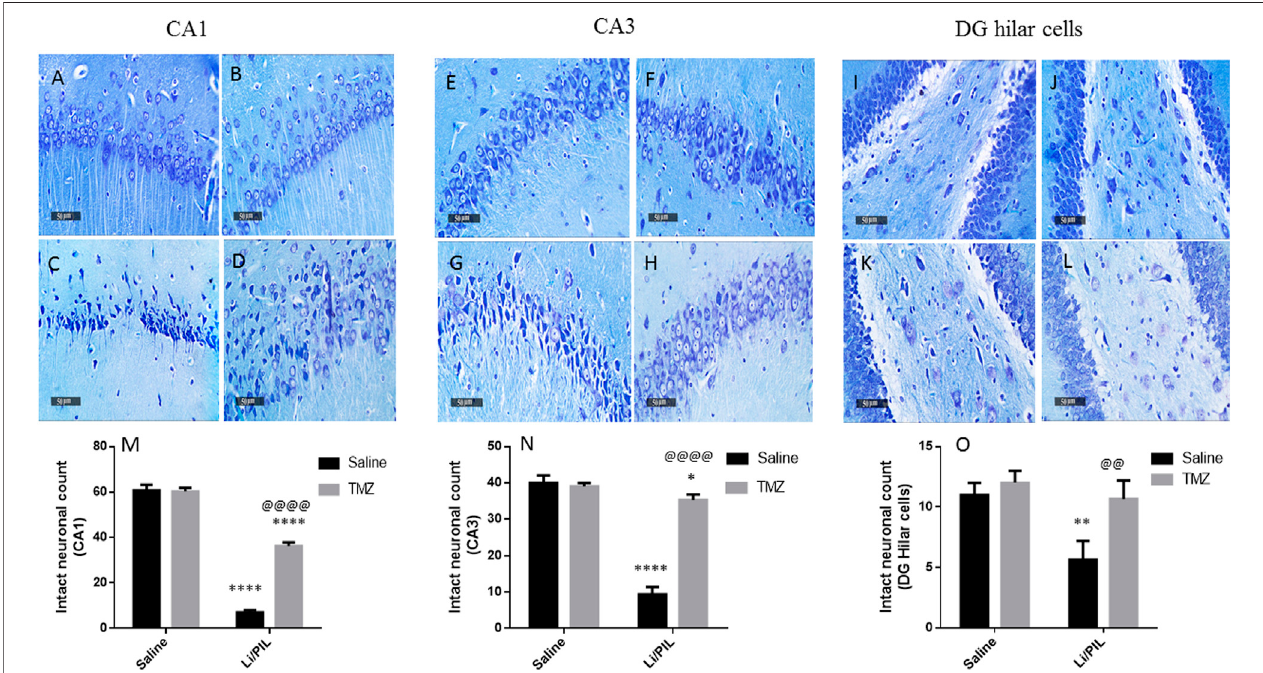
FIGURE 8 | Effect of TMZ on hippocampal neuronal loss of rats with Li/PIL-induced seizures. Photomicrographs demonstrating toluidine blue – stained hippocampaltissuesectionsofCA1andCA3subregionsandDChilarcellsinnormalcontrolrats (A,E,I) ,TMZcontrolrats (B,F,J) ,Li/PILcontrolrats (C,G,K) ,andTMZ+ Li/PILrats (D,H,L) .IntactneuronscountinCA1 (M) ,CA3 (N) ,andDGhilarcells (O) .Valuesareexpressed asmeanofthreeanimals ± SD.Two-wayANOVA followedby the Tukey – Kramer post-hoc test was used for statistical analyses of data. *Signi fi cantly different from the normal control group (Saline) at p < 0.05; **Signi fi cantly differentfromthenormalcontrolgroup(Saline)at p < 0.01;****Signi fi cantlydifferentfromthenormalcontrolgroup(Saline)at p < 0.0001; @@ Signi fi cantlydifferentfromthe Li/PIL control group at p < 0.01; @@@@ Signi fi cantly different from the Li/PIL control group at p <